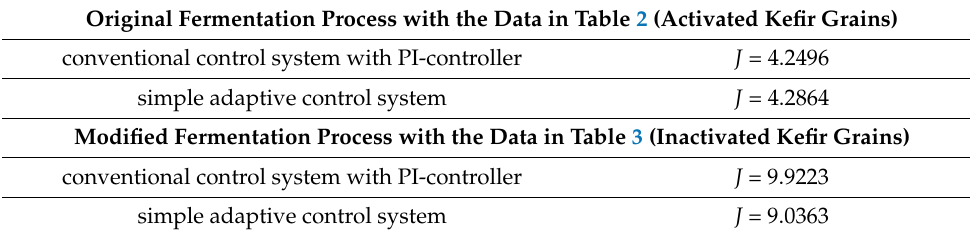
Table 4. Performance indexes for the studied bioreactor’s control